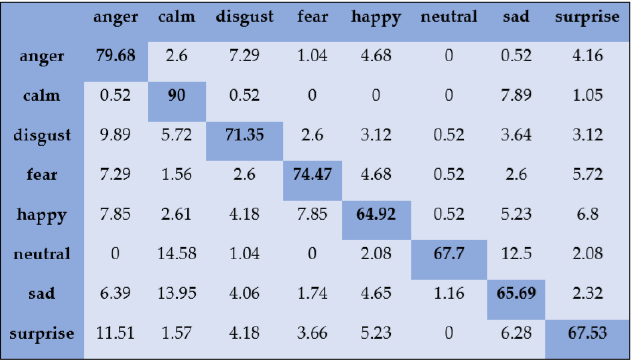
Figure 8. Confusion matrix of RAVDESS dataset for speaker-independent SER.